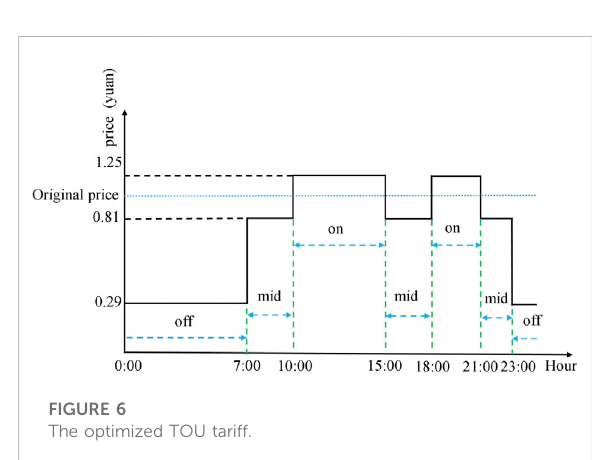
FIGURE 6 The optimized TOU tariff.